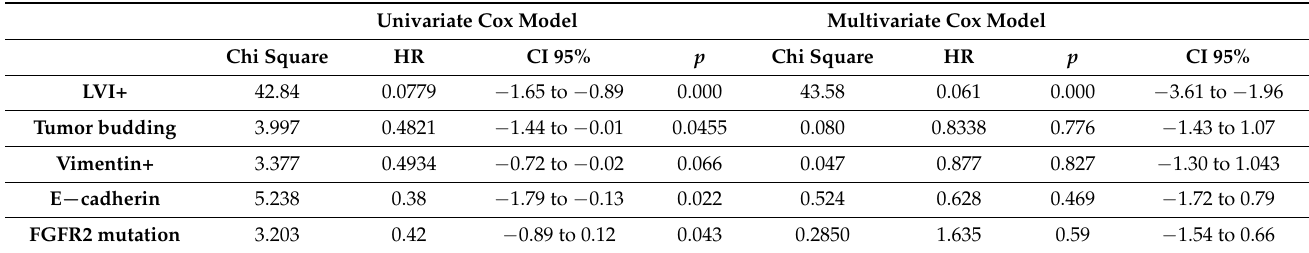
Table 4. A comparison of univariate and multivariate Cox models.